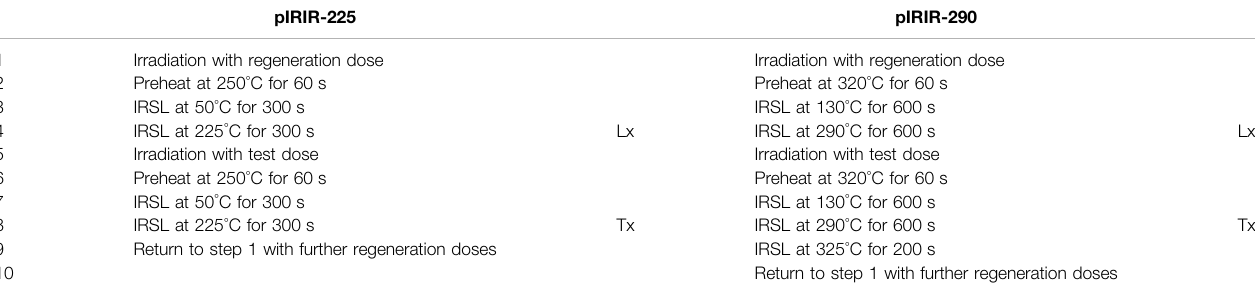
TABLE 1 | Details of the pIRIR-225 and pIRIR-290 protocols used for dating the Achajur polymineral fi ne grain samples.